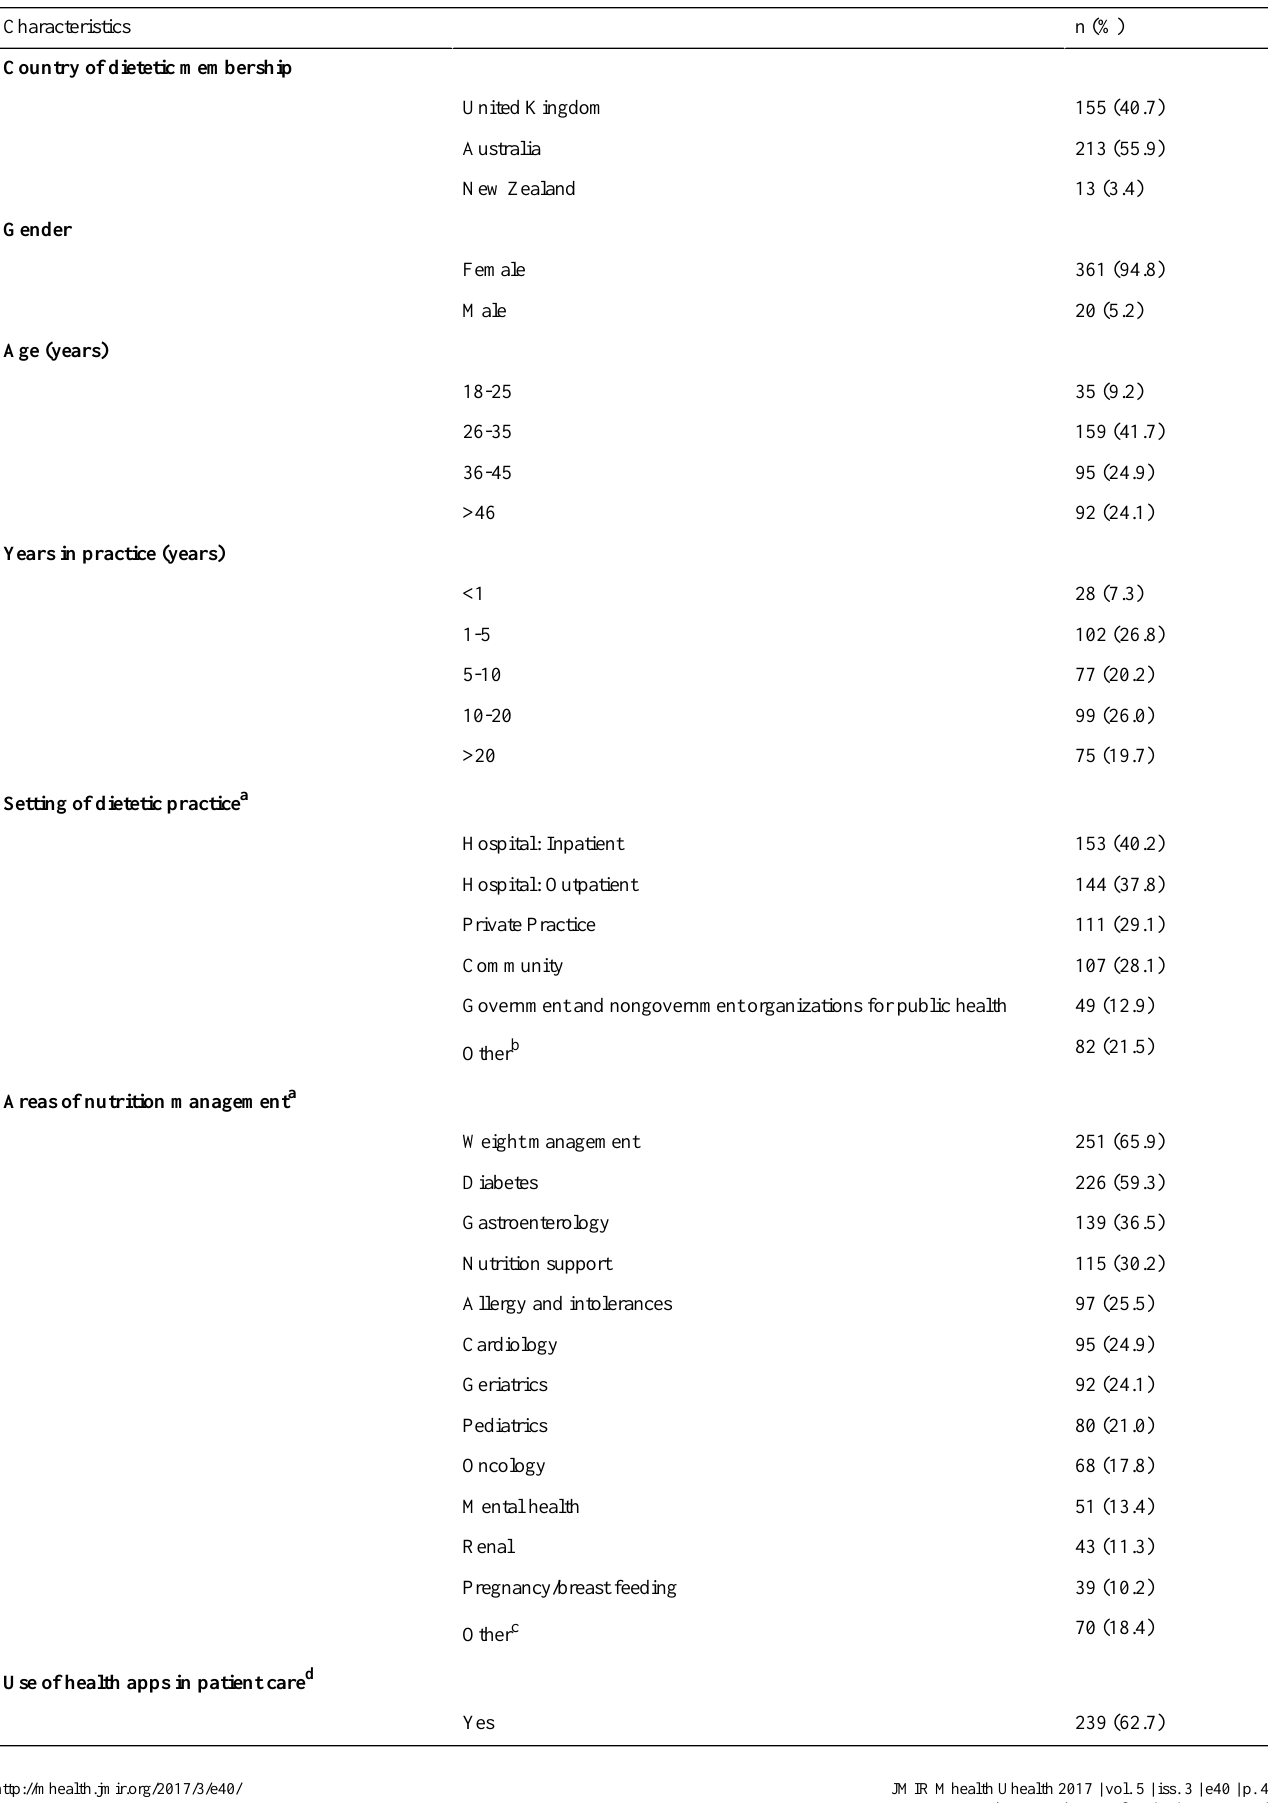
Table 1. Respondent characteristics profile